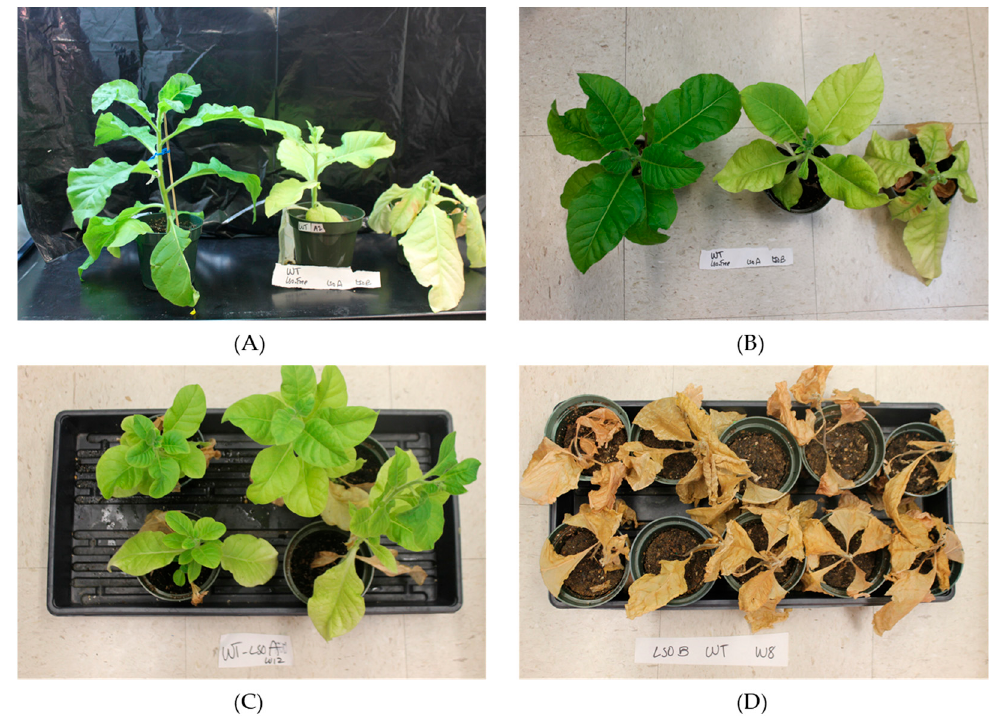
Figure 1. Tobacco plant symptoms. Panels ( A , B ): From left to right, each picture shows a non-infected, a LsoA-, and a LsoB-infected tobacco plant at week 7 post-infestation. Panel ( C ): LsoA-infected tobacco plants at week 12 post-infestation presented severe growth delay and yellowing symptoms but were alive. Panel ( D ): All LsoB-infected tobacco plants were dead.